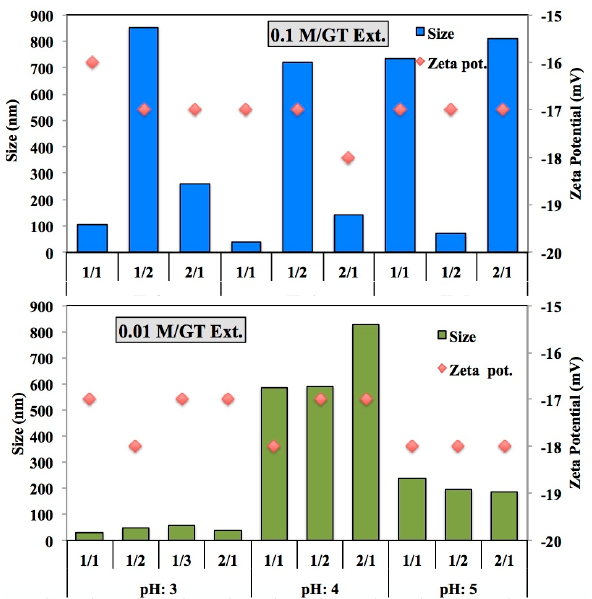
Figure 3. Comparison of the precursor/extract ratio, molarity and pH effect on the GT-ZVI nanoparticles.